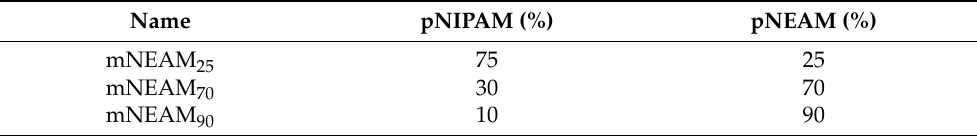
Table 2. Composition of the mixtures of homopolymers.